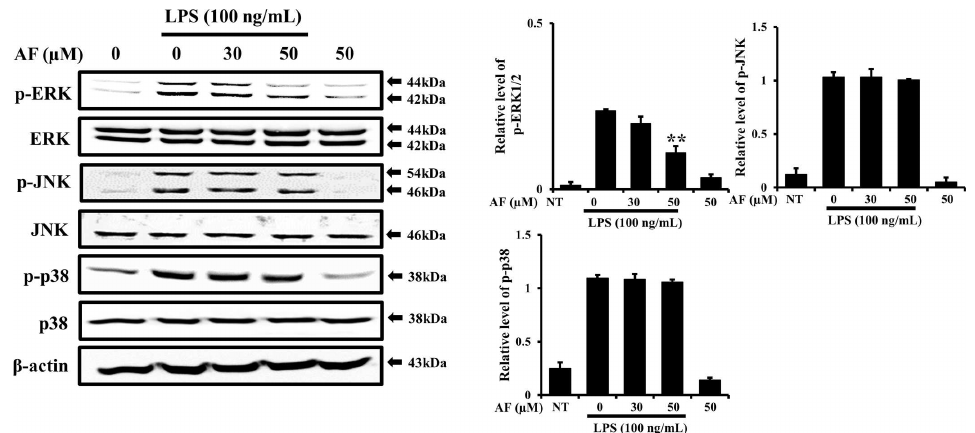
Fig 6. Inhibitory effectsof AF on MAPK phosphorylation in RAW 264.7 macrophage cells. Cells were pre-treatedwith 50 μ M AF for 30 min prior to LPS treatment. After treatment with 100 ng/mL LPS for 15 min, the levels of phosphorylated ERK, p38, and JNK were analyzedby immunoblotting. The levels of ERK, JNK, and p38 were estimated by the loadedprotein as each control. The data shown are representative of three independent experiments and indicatethe mean ± SEM. ** p < 0.01 indicatessignificantdifferences from the LPS alone-treated cells. Probes: NT, no